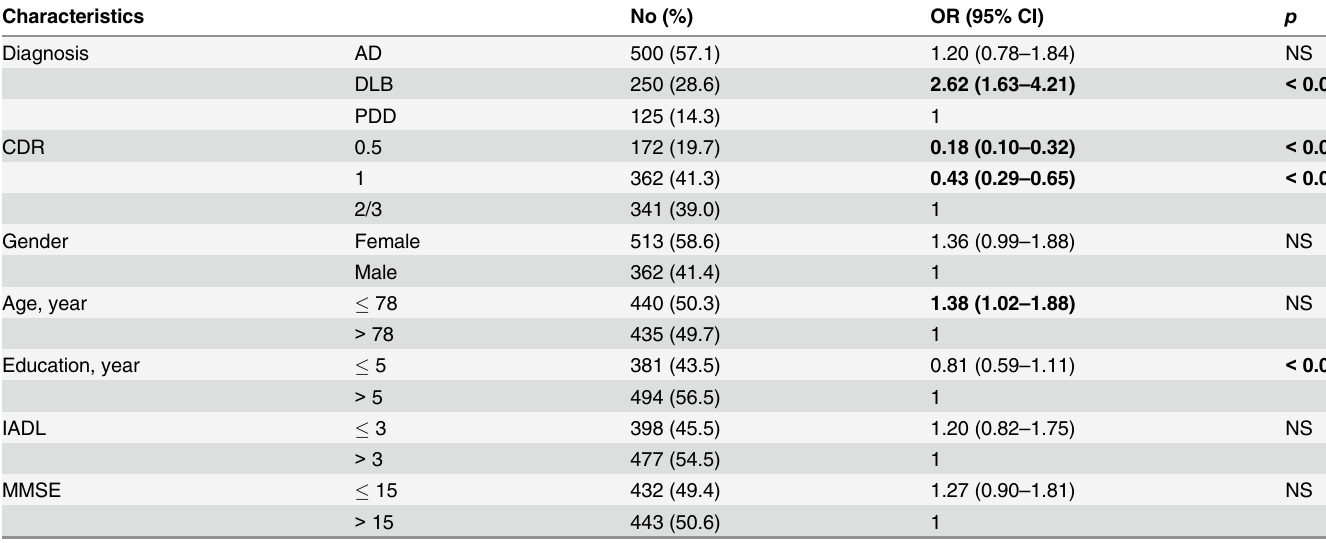
Table 3. Multivariate risk estimates (ORs) for all patients with NPI ≥ 21 (N = 440, 50.3%) compared to those with NPI (cid:1) 20 (N = 435, 49.7%). Characteristics